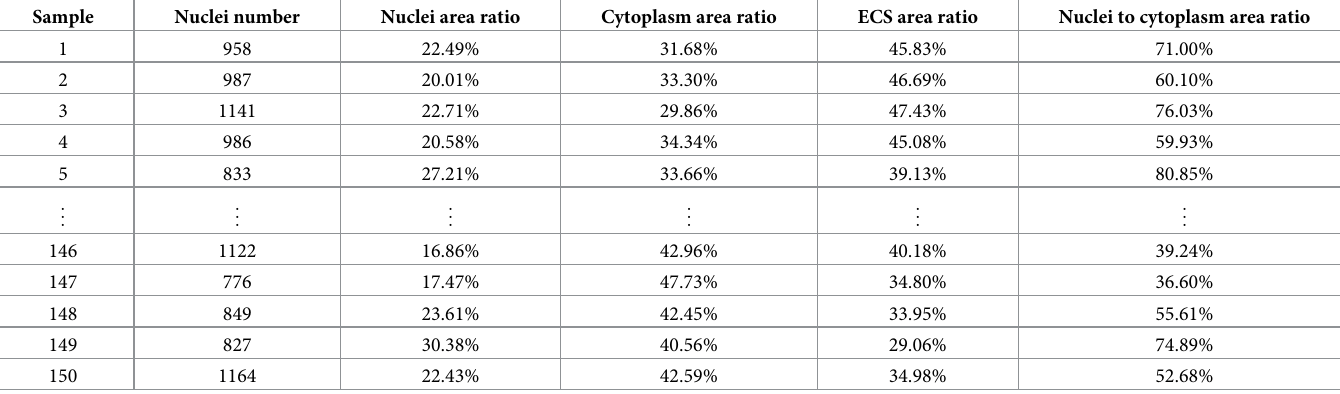
Table 7. Low grade meningioma